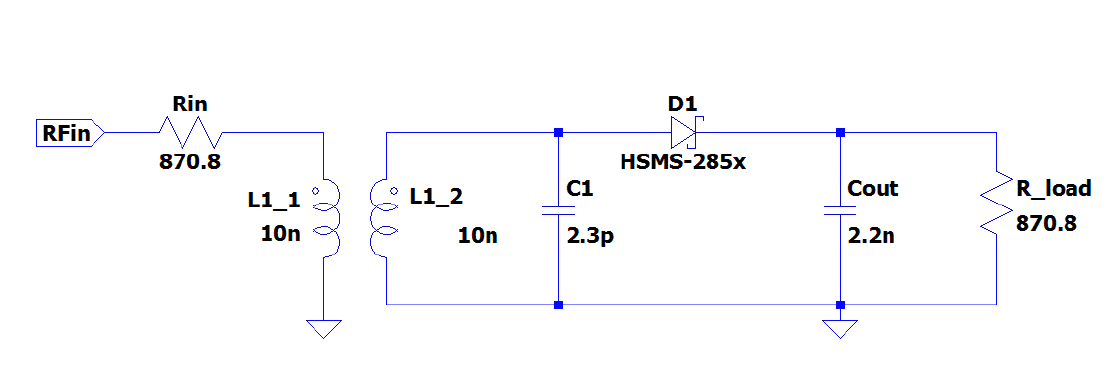
Figure 3. SPICE model of the wide-band rectifier Rect _ B ; values of components are also depicted.